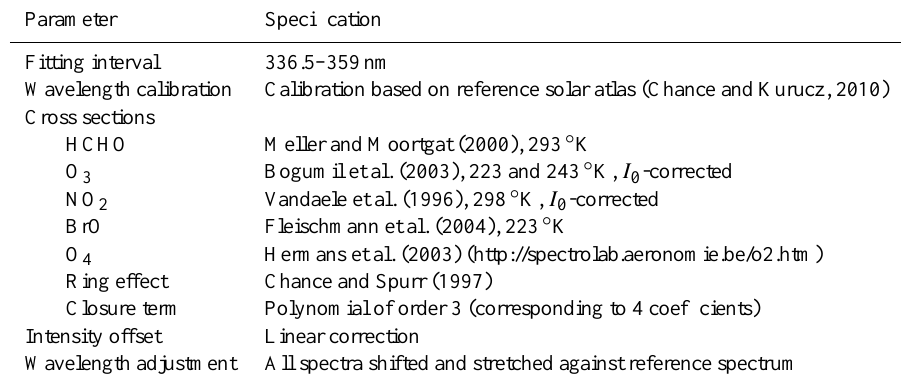
Table 2. Baseline DOAS analysis settings used for HCHO slant column retrieval during the intercomparison exercise.